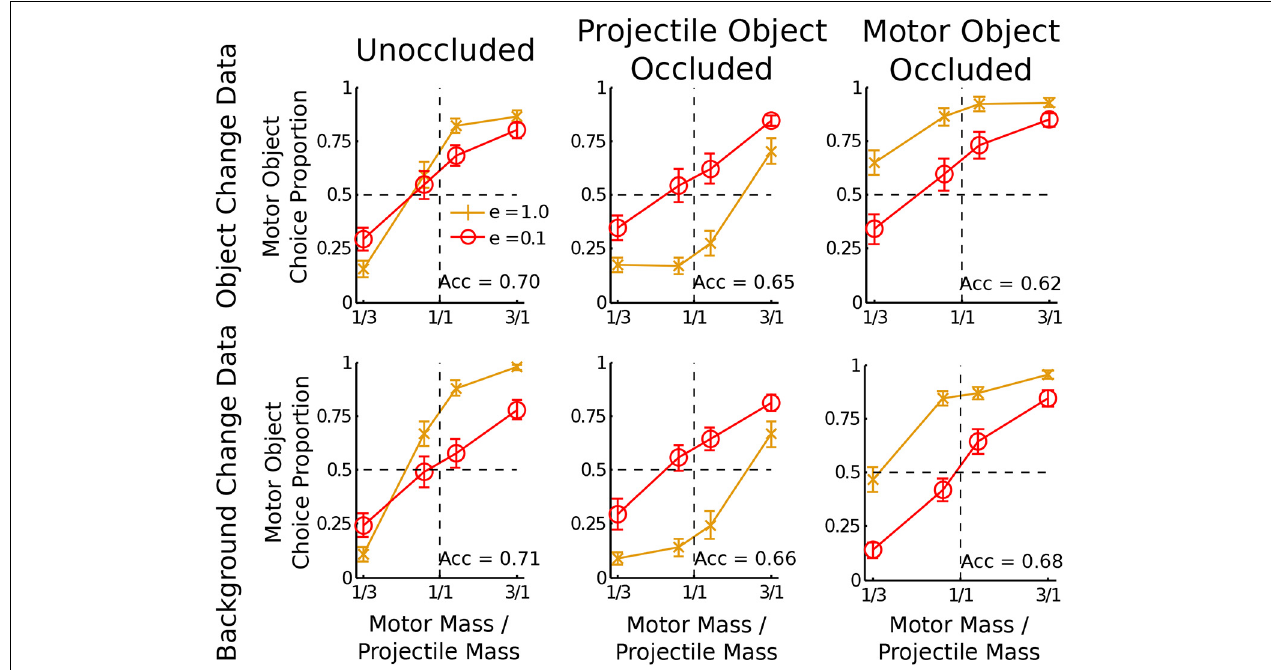
FIGURE 3 | Data from the object change and background change participants for different types of occlusion conditions. The horizontal axis is the mass ratio of the motor object to the projectile object. The vertical axis is the proportion of trials on which participants decided the motor object